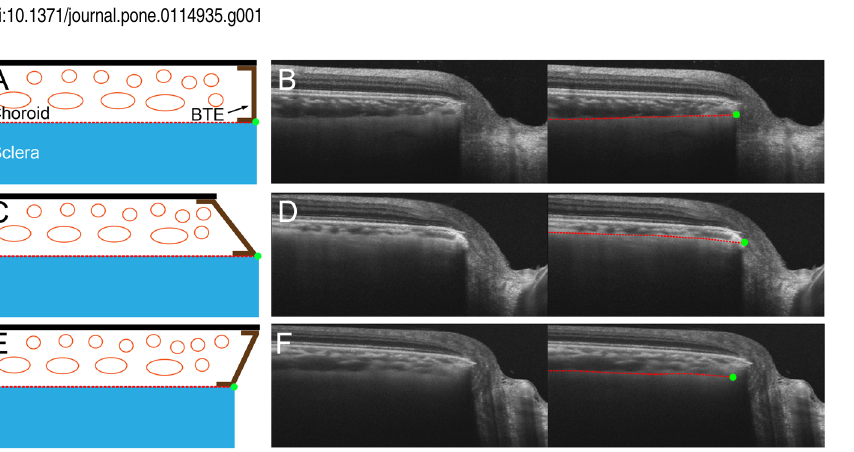
Fig. 1. Measurement of the anterior lamina cribrosa insertion (ALI) position and marginal anterior laminar cribrosa depth (mALCSD). A. SS-OCT image without labels. B. SS-OCT image after adaptive compensation. C. Measurement of ALI distance (ALID). The yellow line indicates the anterior lamina cribrosa surface, and the white lines indicate the choroidoscleral interface. ALID (red arrow lines) was defined as the distance from the anterior scleral canal opening (green dots) to the meeting point of the anterior laminar surface and the scleral canal wall (yellow dots). D. mALCSD (red arrow lines) was defined as the perpendicular distance from the anterior scleral canal opening plane (green dashed line) to the anterior lamina cribrosa surface (yellow line) at the location of the anterior scleral canal opening (green dots). E. Alignment of the SS-OCT scans to the fovea–Bruch’s membrane opening center axis (foBMO axis), obtained using Spectralis infrared (IR) fundus photography (upper left). The SS-OCT IR fundus photography (upper right), which contains 12 lines indicating the location of the scan, was overlapped with the Spectralis IR fundus photograph (lower). The SS-OCT radial scan line that was closest to the foBMO axis (thin arrow) was defined as the 9 o 9 clock meridian (thick arrow). Note that the numbers in the SS-OCT IR fundus photography represent the serial number of the scans, not the clock-hour meridian.